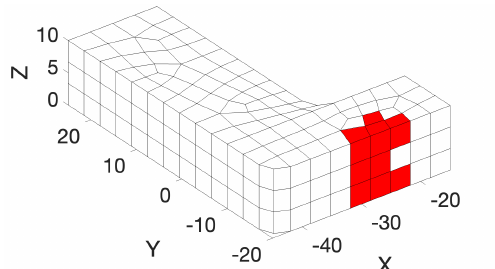
Figure 15. Identified elements affected by the damage (in red) at the first iteration ( q = 1) of the algorithm proposed in Section